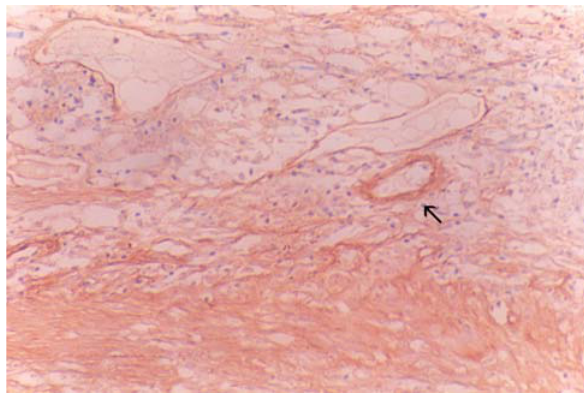
FIGURE 3 - Fibronectin immunoreactivity in central giant cell granuloma of the jaws. Fibrillar organization pattern following the collagen fibers (SABC – 200x)